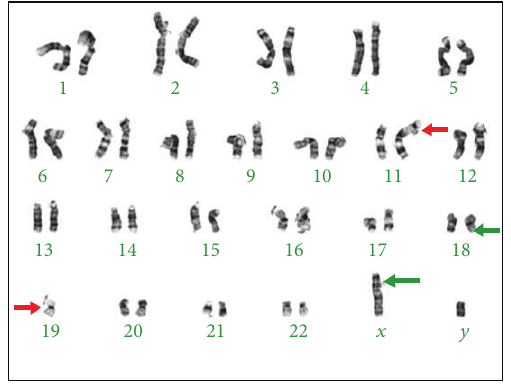
Figure 4: Karyotype showing characteristic X;18 translocation (green arrows) as well as association of chromosome 19 with telo- mere of chromosome 11 (red